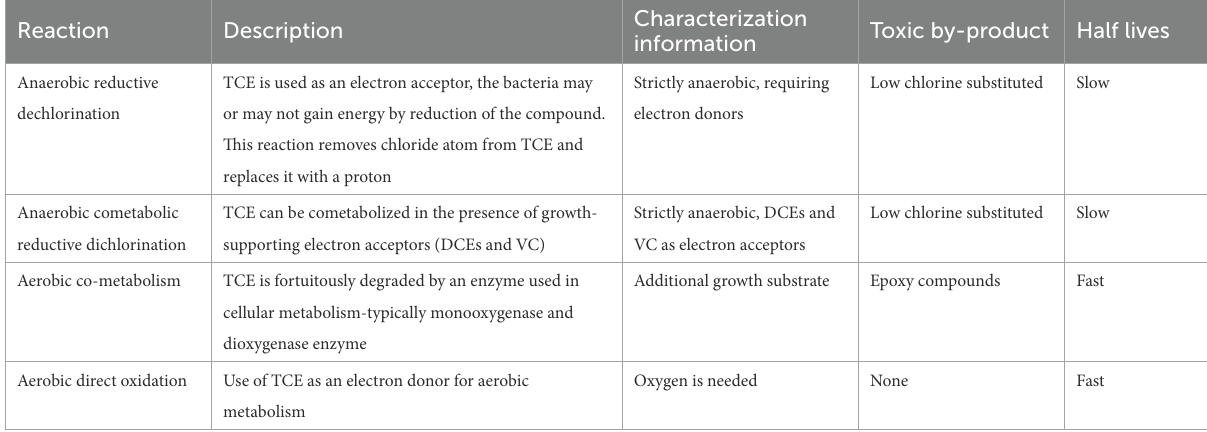
electron transfer with Co I being the initial electron donor; and (3) Path C: halogen-cobalt bond formation. Among these three sphere, which suggested that electrons were transferred from Co I